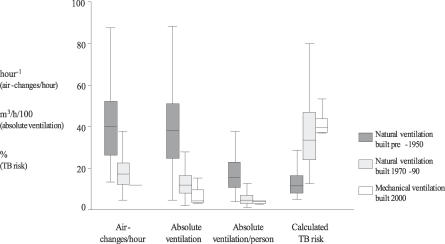
Ventilation and Protection against Airborne TB Transmission in Old-Fashioned Compared with Modern RoomsVentilation and protection against airborne infection is shown for pre-1950 versus modern (1970–1990) naturally ventilated facilities versus mechanically ventilated negative-pressure respiratory isolation rooms. The triplet of bars on the left represents ACH in old-fashioned, high-ceilinged, pre-1950 naturally ventilated clinical areas (n = 22; 201 experiments), versus modern naturally ventilated facilities (n = 42; 125 experiments), versus mechanically ventilated negative-pressure facilities (n = 12). The left-centre triplet of bars represents the same comparison for absolute ventilation (m3/h/100); the right-centre triplet of bars represents that for absolute ventilation per person (m3/h/100); and the triplet of bars on the right that for the estimated risk of airborne TB transmission (percentage of susceptible persons infected), for 24-h exposure to infectious TB patients [17]. Data are shown for 64 naturally ventilated rooms with windows and doors fully open (the remaining six naturally ventilated rooms had windows that could not be fully opened).